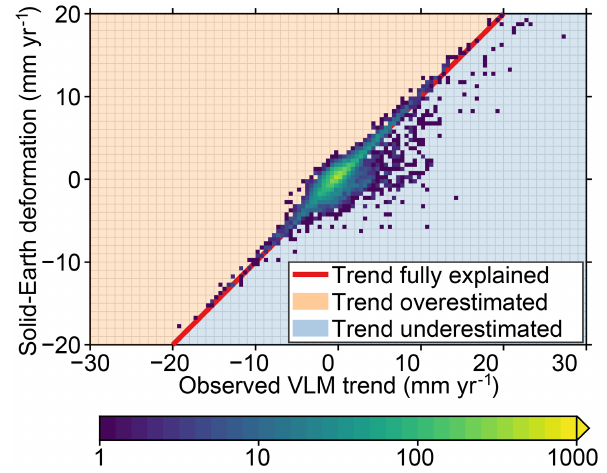
Figure 12. Scatter plot of observed VLM trends (Fig. 10a) versus the trend in SED resulting from GIA and contemporary mass re- distribution (Fig. 11i). The color denotes the number of stations for each trend pair within 0.5mmyr − 1 . For points on the red line, the observed VLM trend and SED trend agree completely; in the orange area, the SED trend is larger than the observed VLM trend; for the blue area, the SED trend is smaller than the observed VLM